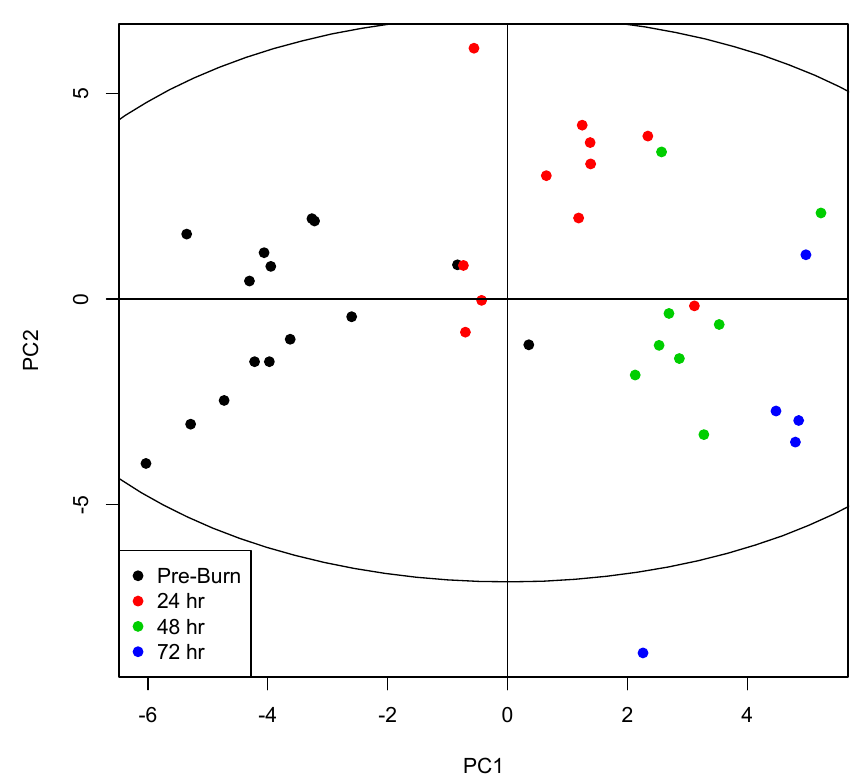
Figure 1. Principal component scores for components 1 (PC1) and 2 (PC2) were plotted for each sample. Samples were then colored by experimental timepoint to illustrate sample clustering.